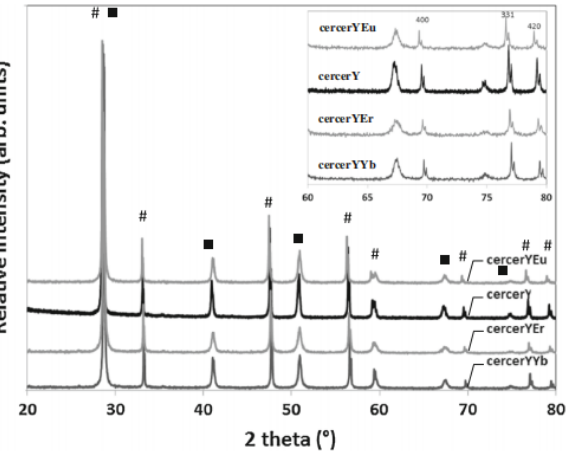
Figure 9. XRD of sintered cercer Y, cercer YYb, cercer YEu, and cercer YEr membranes.  , perov- skite phase; #, fluorite phase [65]. phase; #, fluorite phase